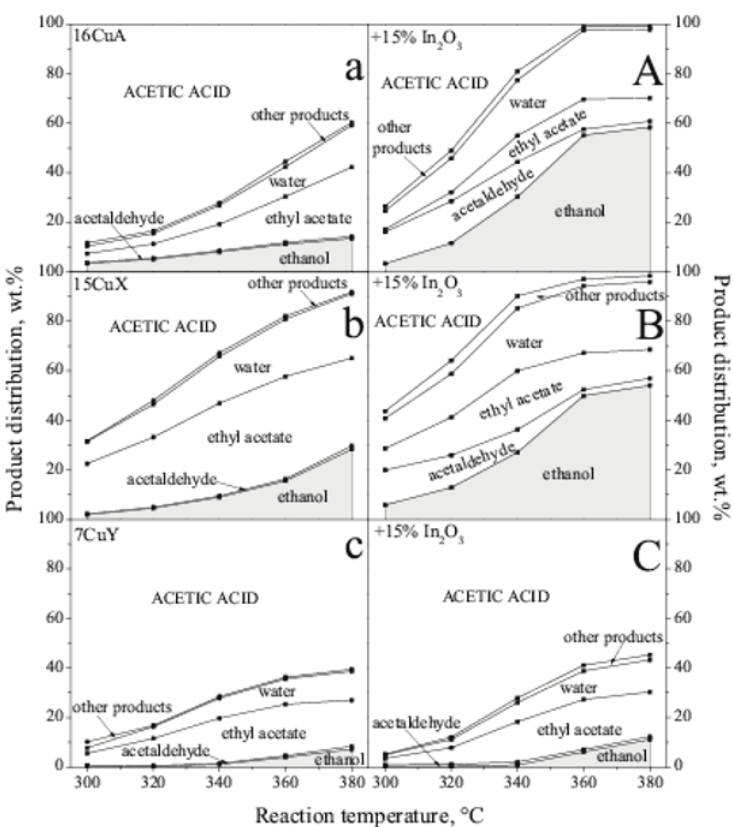
Figure 2. Product distribution of 16CuA (a,A), 15CuX (b,B), 7CuY (c,C) catalysts and (A, B, C) their composites with 15 wt.% In conversion of AA as function of reaction temperature at 21 bar in stacked area graphs. The partial pressures of AA and H 18.9 bar. The WHSV of AA was 1 h -1 (calculated for the CuZ mass only). The temperature was increased in 20°C steps. Data represent steady-state